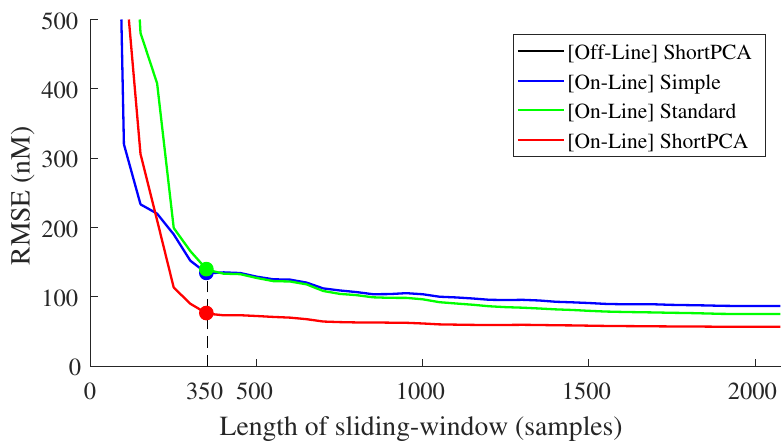
Figure 4. RMSE estimated by different-window-length SWA ranging from 50 to 2077 samples at 50 sample intervals. Colored circles at 350 samples represent the same results as in Section 4.1.